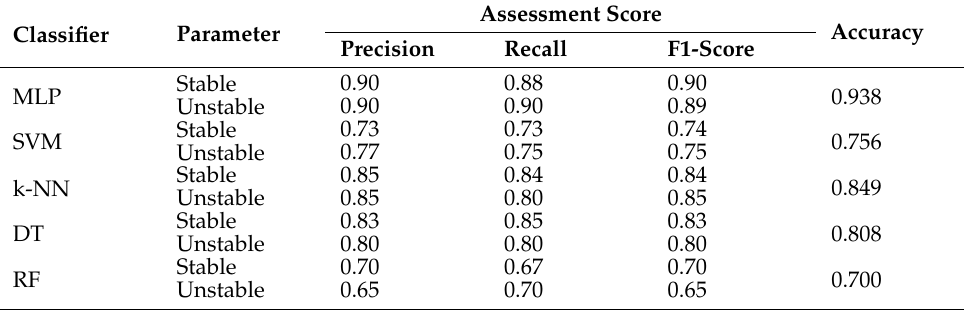
Table 3. The performance matrix for further predictive models.